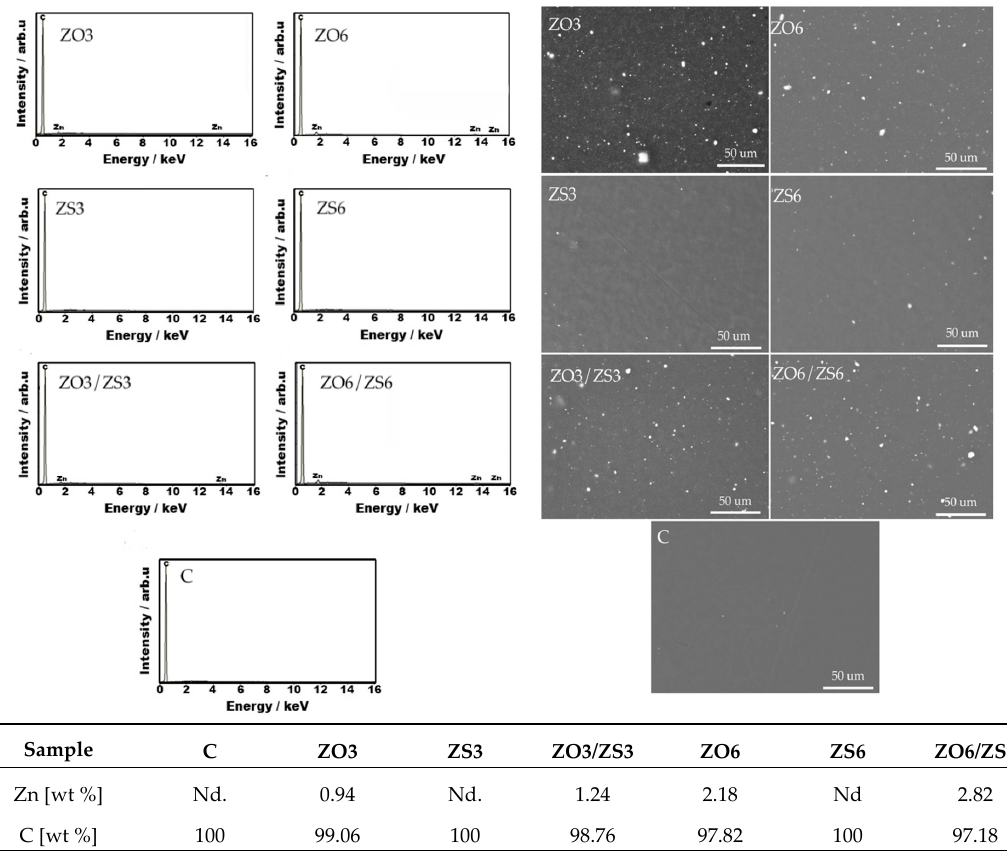
Figure 2. Composition of PE films containing a masterbatch with zinc oxide (ZO) and / or zinc stearate (ZS) compared with EDX spectra and SEM image of surface morphology at 500× magnification.